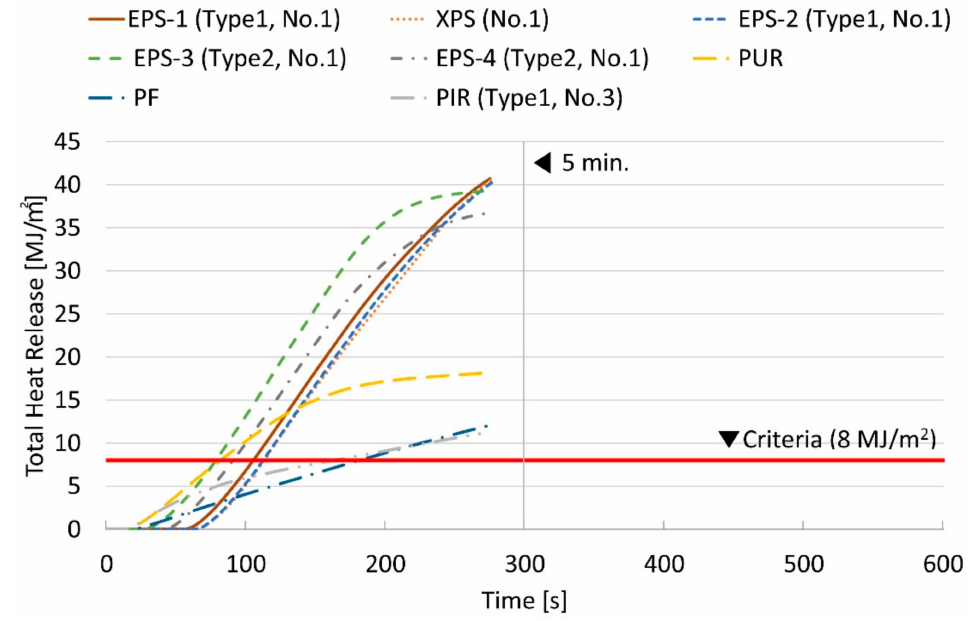
Figure 4. THR with foamed plastic insulation specimens according to the cone calorimeter.